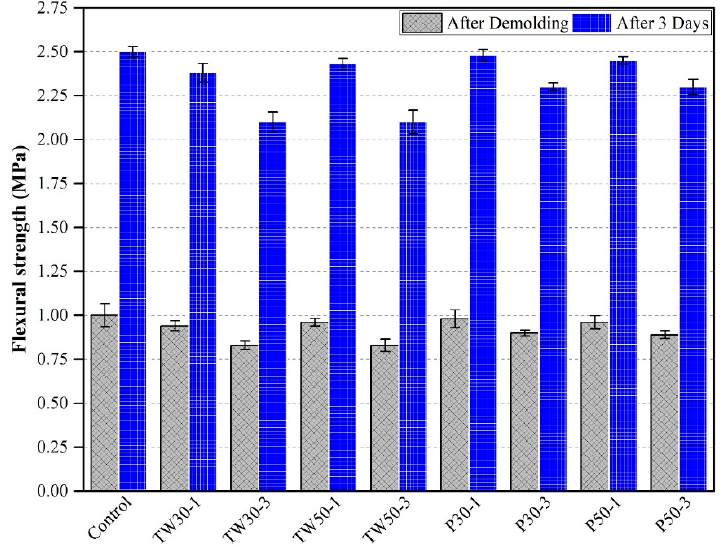
Figure 9. Flexural strength of specimens.